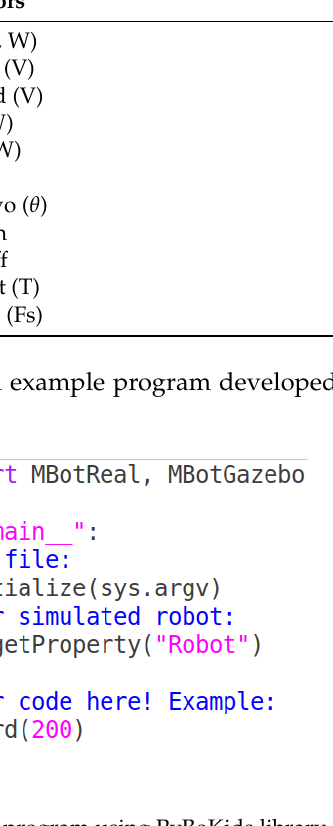
Figure 5. Python example program using PyBoKids library